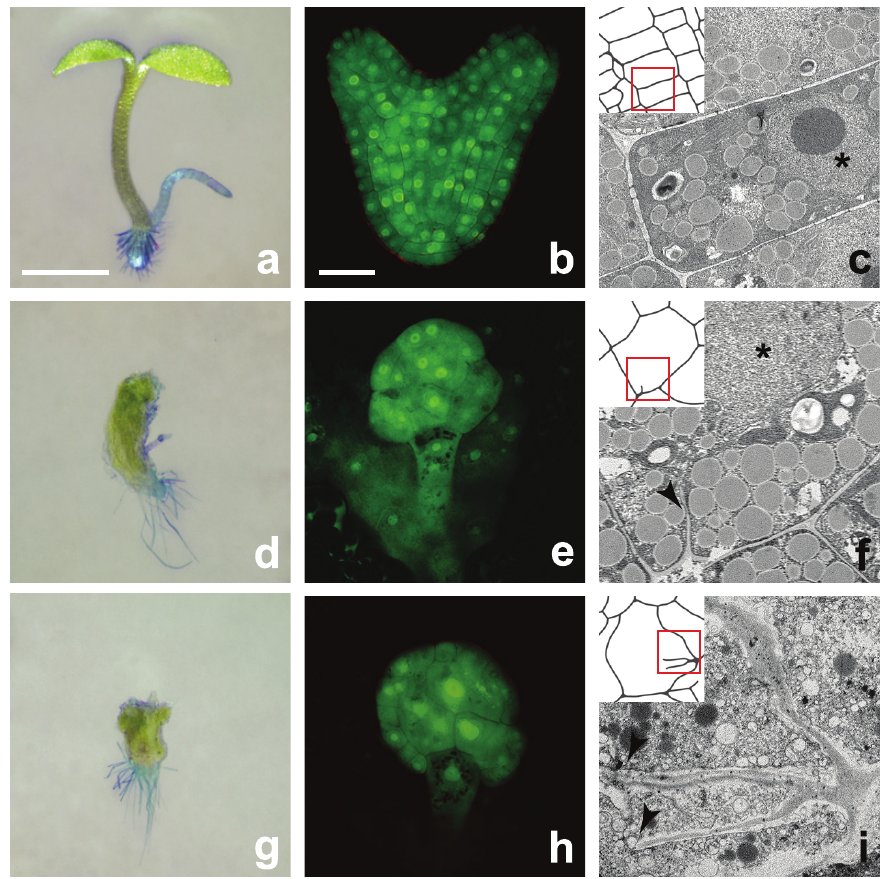
Fig 2. Morphological and ultra-structural characteristics of tio and rsw mutants. Left: Seedling morphology. Images of wild type ( a ) tio-12 ( d ) and rsw-lph ( e ) seedlings; root hairs were contrasted with methylene blue; scale bar equals 1 mm. Center: Anatomy of embryos. Confocal micrographs of wild type ( b ), tio-12 ( e ), and rsw-lph ( h ) embryos at the heart stage of development stained with Alexafluor 488 hydrazide; scale bar equals 30 μ m. Right: Ultra-structure of embryonic cells. Transmission electron micrographs showing cells of wild type ( c ), tio-10 ( f ) and rsw-lph ( i ) embryos; the arrowheads point to cell wall stubs, and the stars in ( c ) and ( f ) mark the nucleus; the side of panels equals 10 μ m.